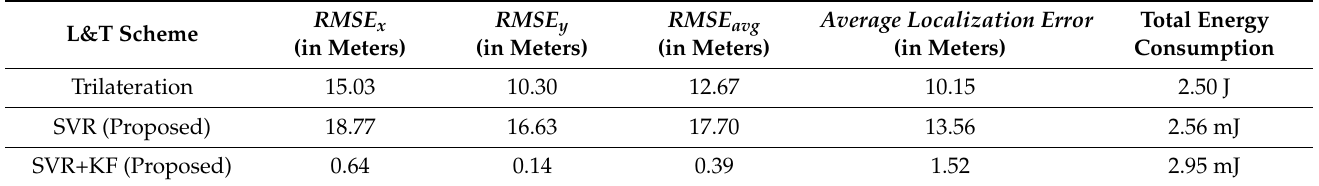
Table 6. Average localization error and RMSE for case